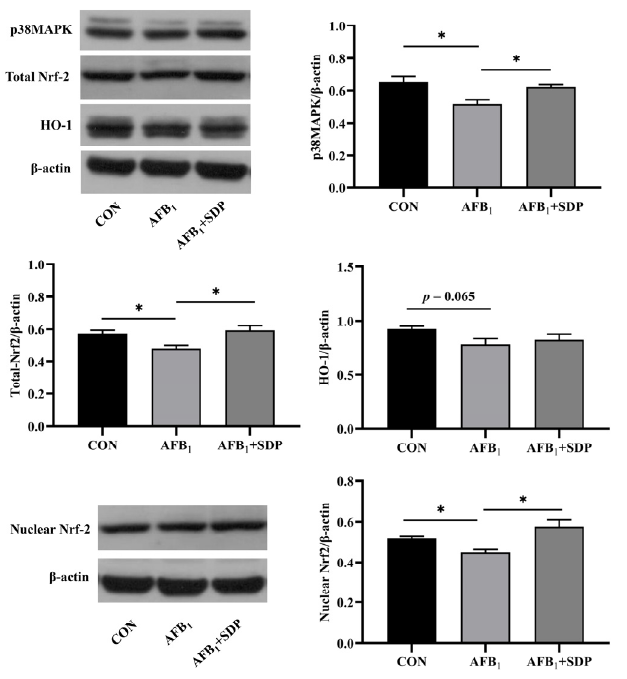
Figure 7. The protective effects of dietary seaweed ( Enteromorpha prolifera )-derived polysaccharides on hepatic protein expression of p38MAPK, HO-1, total Nrf2, and nuclear Nrf2 in broiler chickens. * p < 0.05, no superscript marks indicated that p > 0.10. CON: control group; AFB 1 group (fed diet with 0.1 mg/kg AFB 1 ); AFB 1 + SDP group (AFB 1 group + 0.25% SDP).